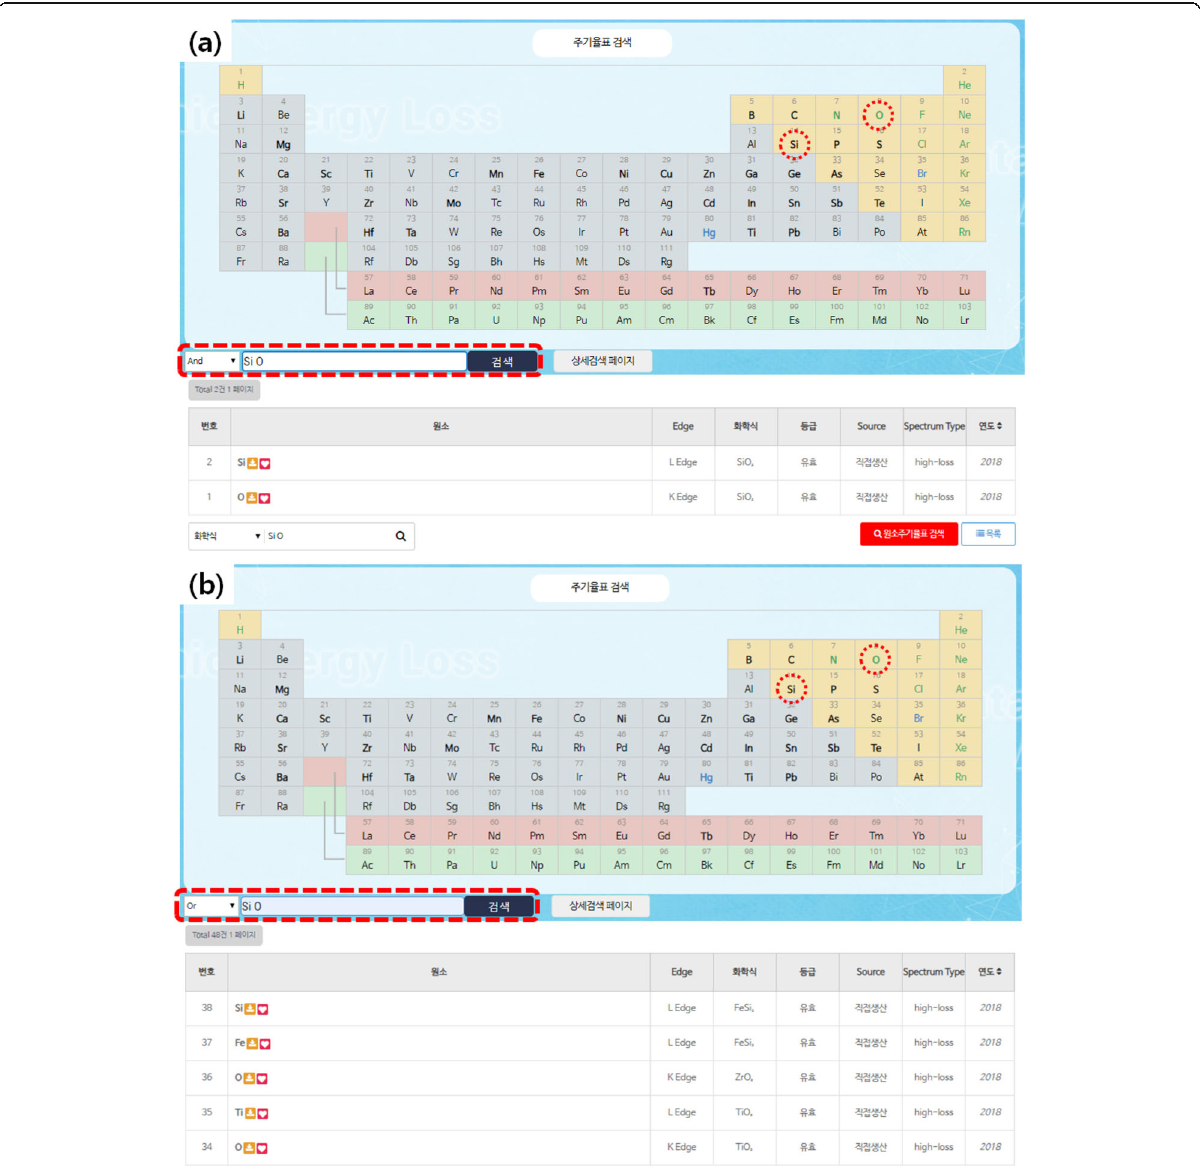
Fig. 3 Data search methods and their retrieved results. a Searching for Si and O by selecting ‘ and ’ results in the materials containing both Si and O. b Searching for Si and O by selecting ‘ or ’ results in the materials containing Si or